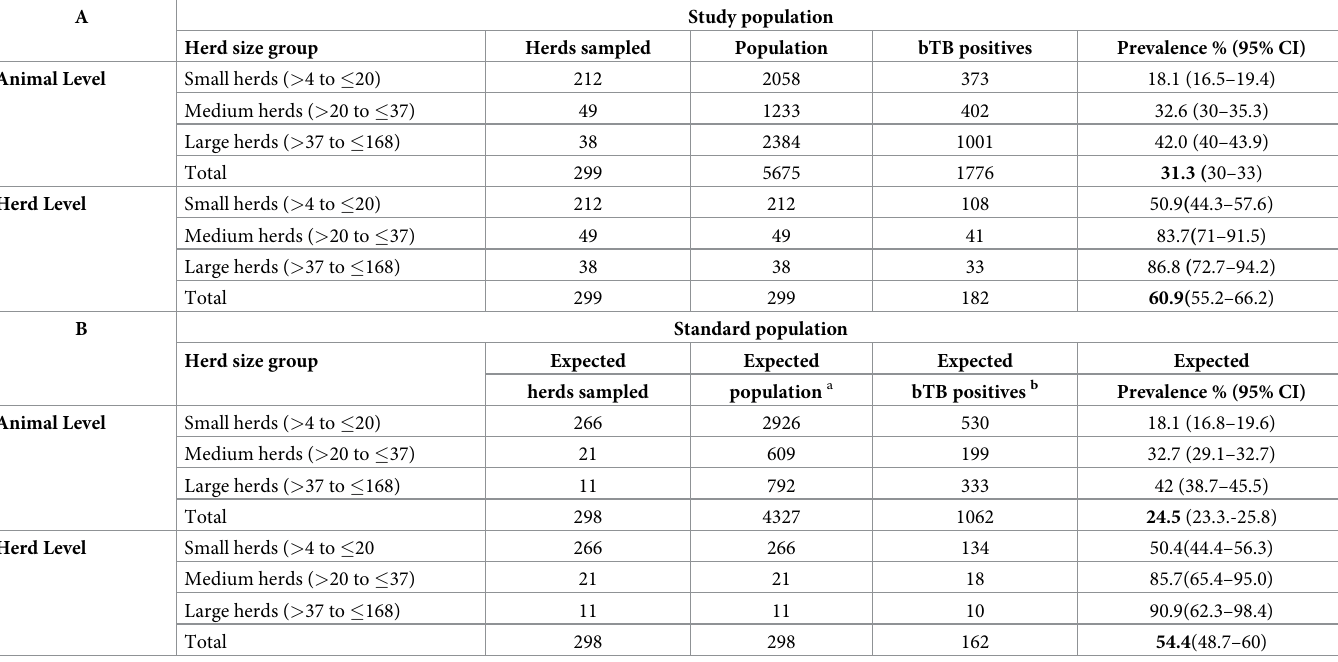
Table 3. Prevalence of bTB stratified by herd-size for (A) the study population and (B) the standard population of the study areas.